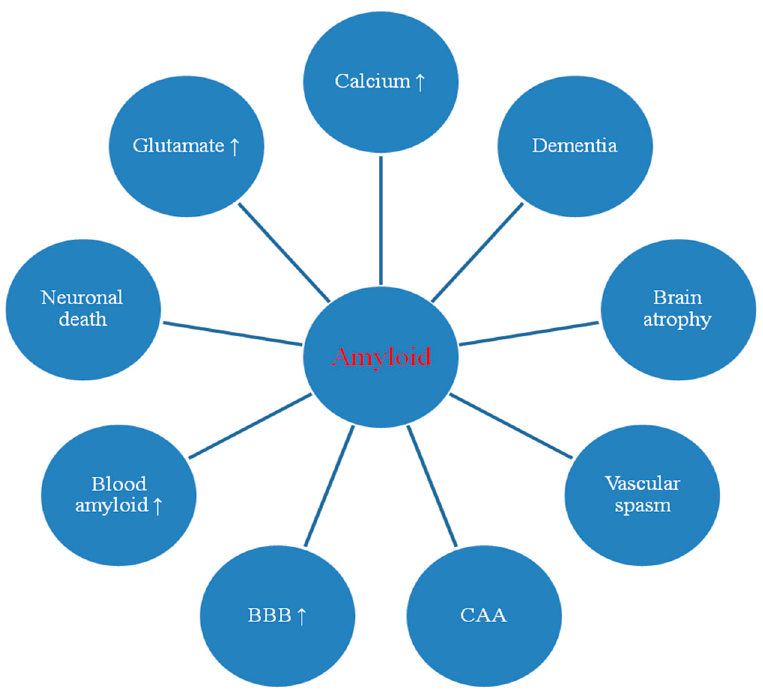
Figure 1. Potential pathological role of amyloid during ischemia-reperfusion brain injury. BBB: blood-brain barrier; CAA: cerebral amyloid angiopathy; ↑ : increase.